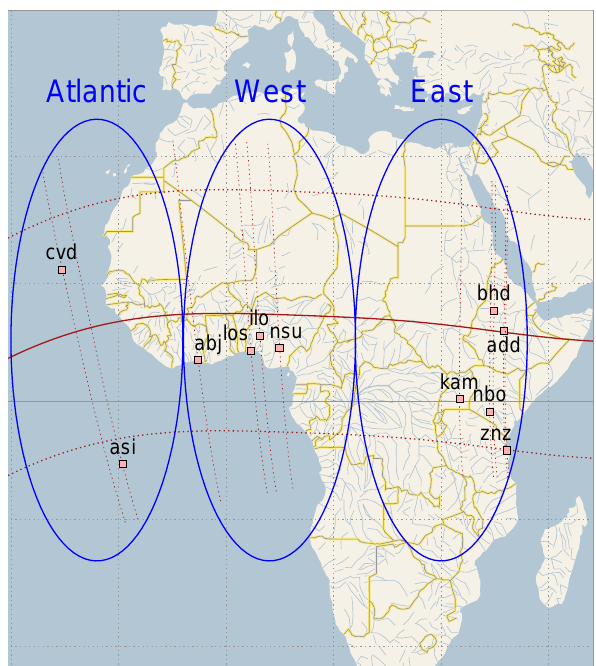
Fig. 1. SCINDA station locations in equatorial Africa. The geo- magnetic field configuration is shown as well; the solid curve indi- cates the dip equator, the horizontal dotted curves indicate ± 20 de- gree dip latitudes, and the dotted vertical curves show the magnetic meridians through the stations. Three geographical regions (At- lantic, West, and East) can be introduced using the existing stations.